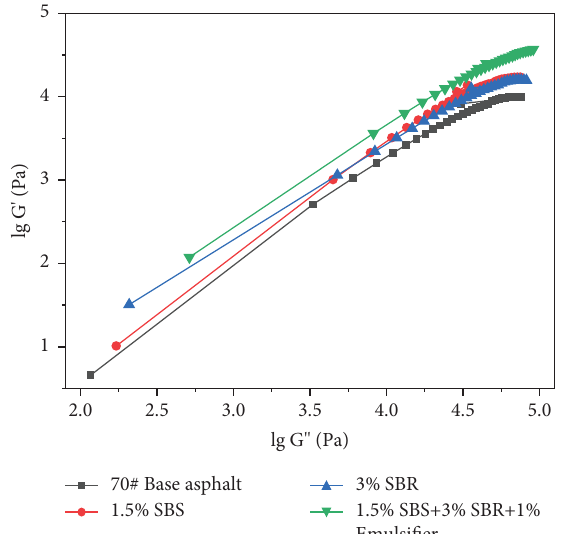
Figure 10: Han curves of four emulsifed asphalts under frequency sweep. Table 10: Fitting parameters of four emulsifed asphalt Han curves under frequency sweep. Asphalt type Slope ( k ) R 2 Base emulsifed